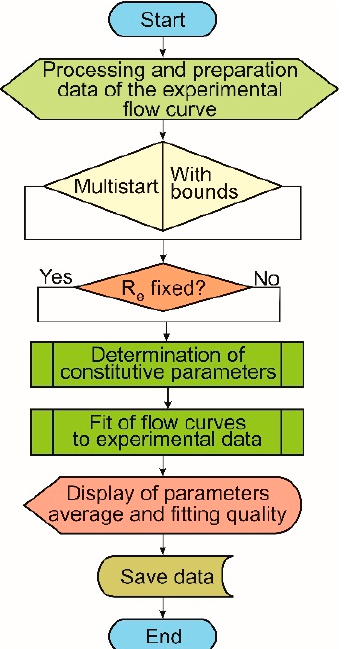
Figure 7. Flow chart of algorithm for the simultaneous determination of constitutive parameters.